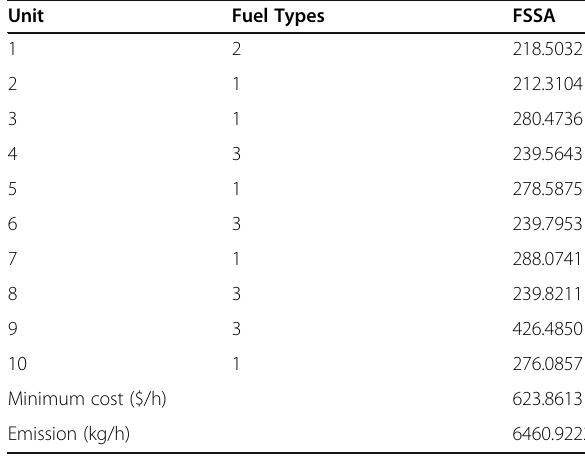
Table 2 Optimal solution acquired by the proposed